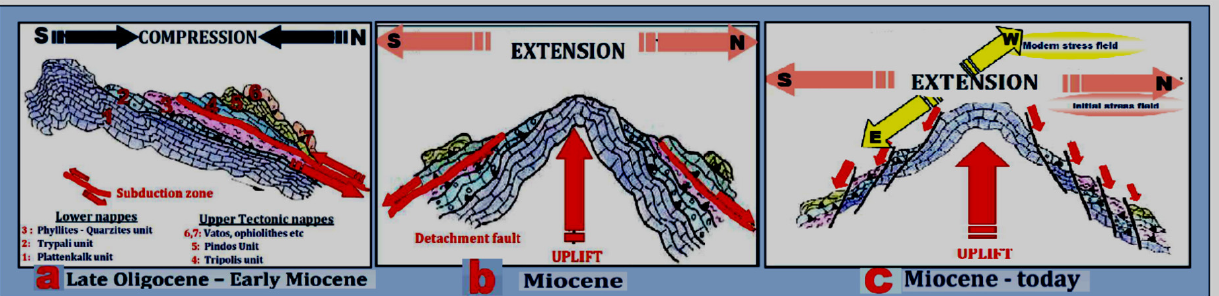
Figure 7. Development of the “Lefka Ori” mountains’ geological structure, under the corresponding stress fields (stages a – c ), which were developed within the geodynamic evolution of the wider area, as analyzed in the text [18,19] .